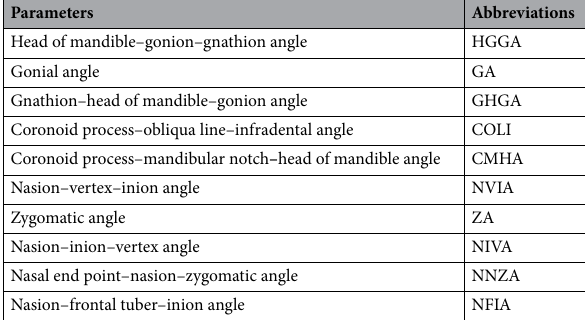
Table 6. Angle parameters and abbreviations.